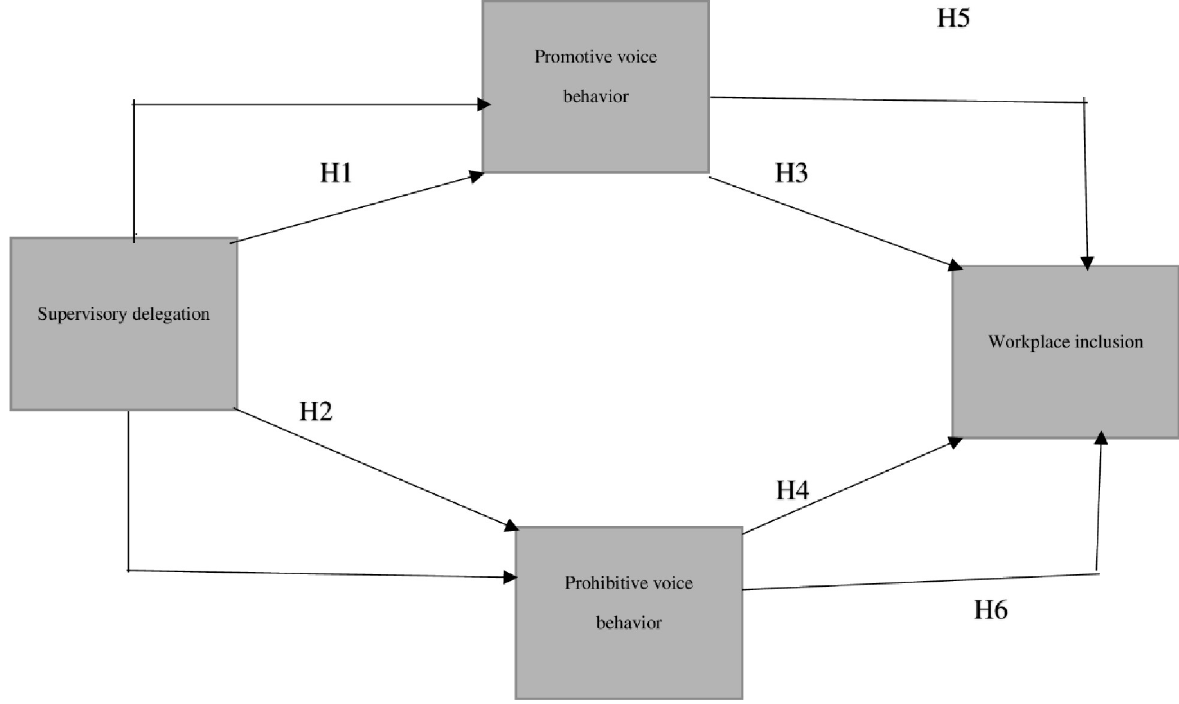
Fig 1. Conceptual representation of study